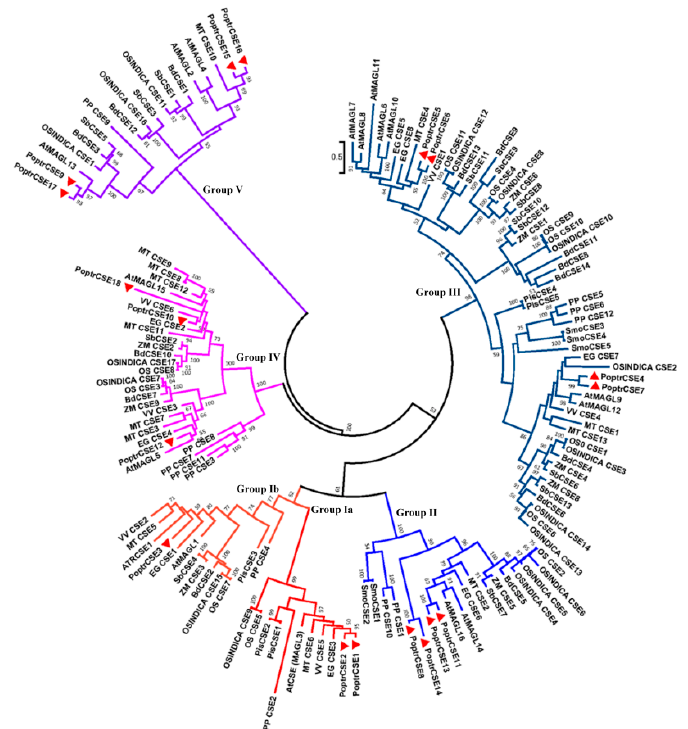
Figure 4. Phylogenetic tree of screened CSE and CSE-like protein sequences from Populus and other species. Eighteen PoptrCSE or PoptrCSE-like proteins are marked with red triangles. All 153 CSE and CSE-like proteins including AtMAGLs are listed in Supplementary Table S5.